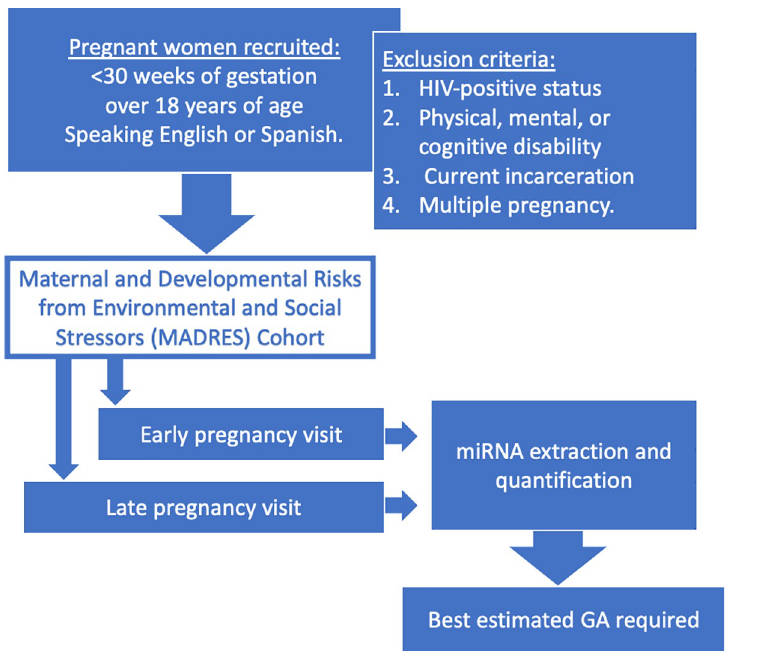
Fig 3. Recruitment and study flow